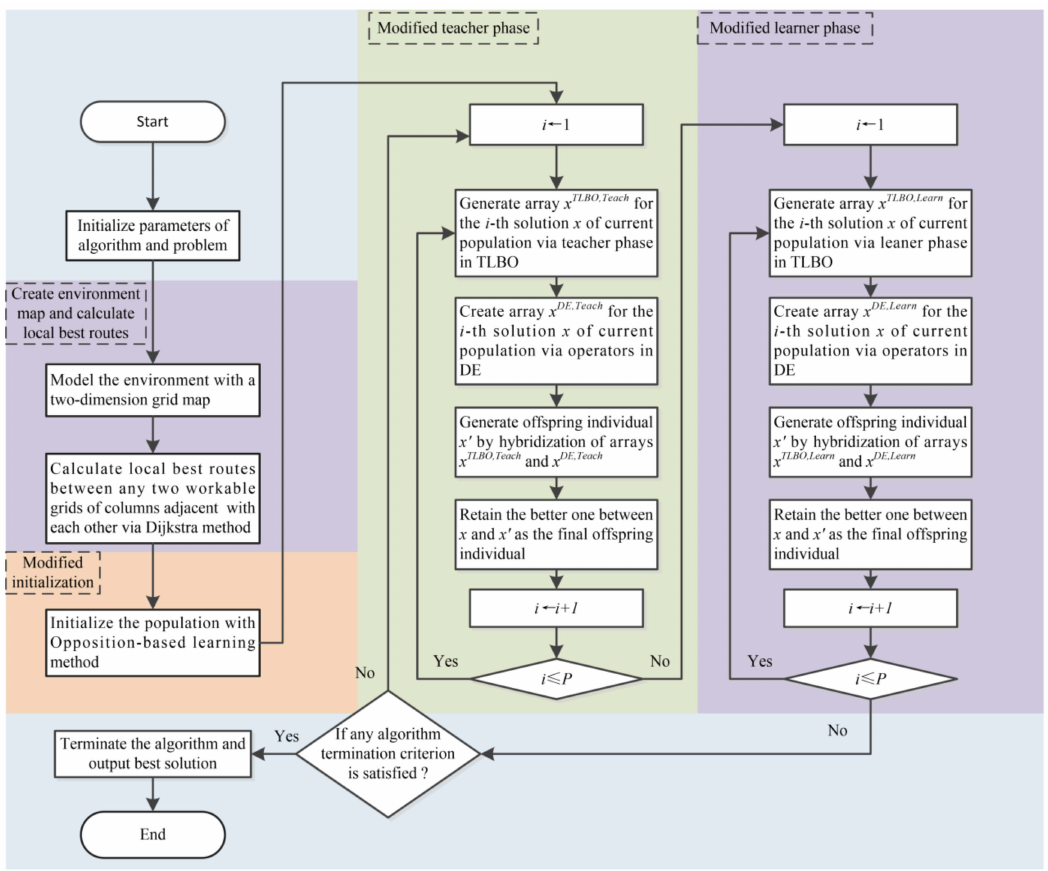
Figure 5. Proposed ETLBO for the